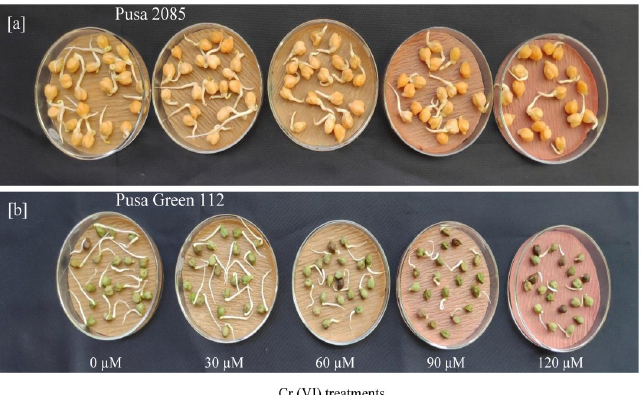
Fig 2. Germination performance of seeds in two chickpea varieties under different chromium (Cr) treatments. (a) Pusa 2085. (b) Pusa Green 112.